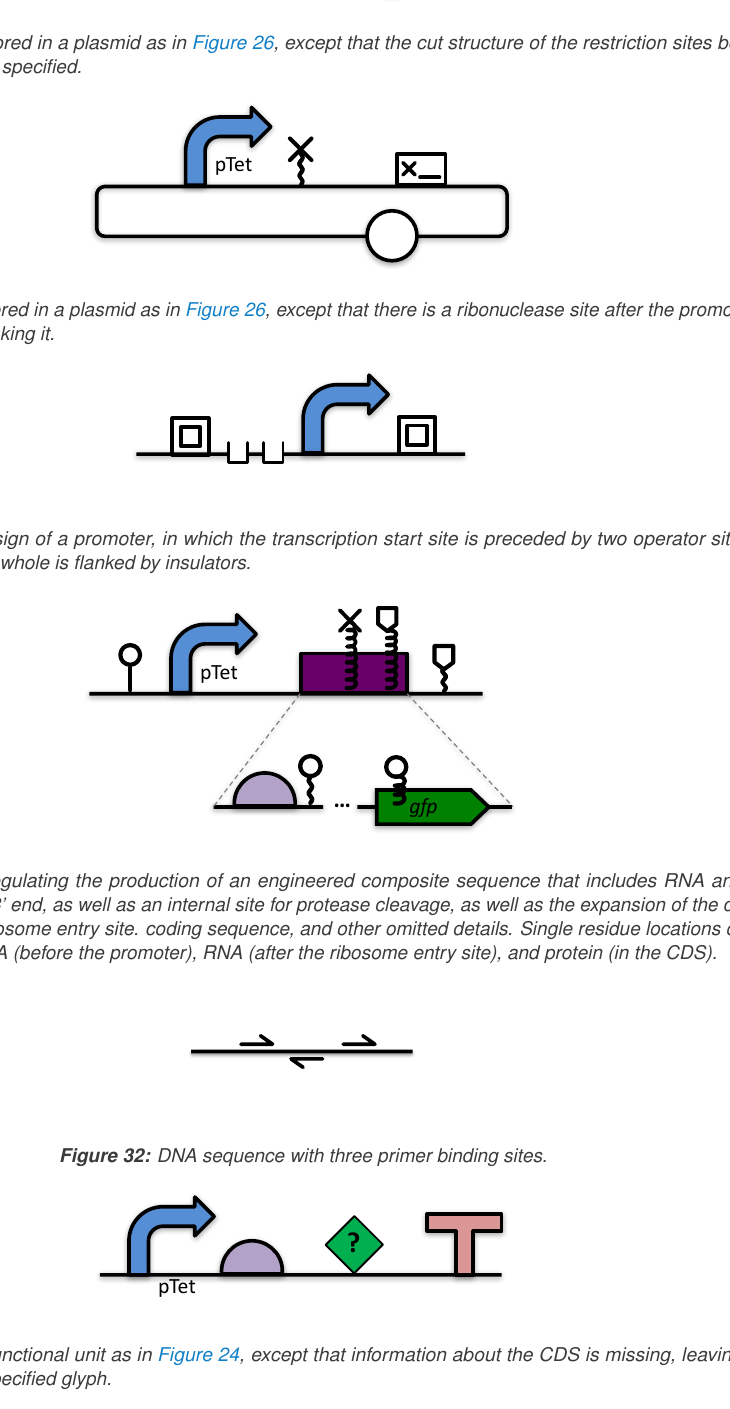
Figure 33: The same functional unit as in Figure 24, except that information about the CDS is missing, leaving it to fall back on the default unspecified